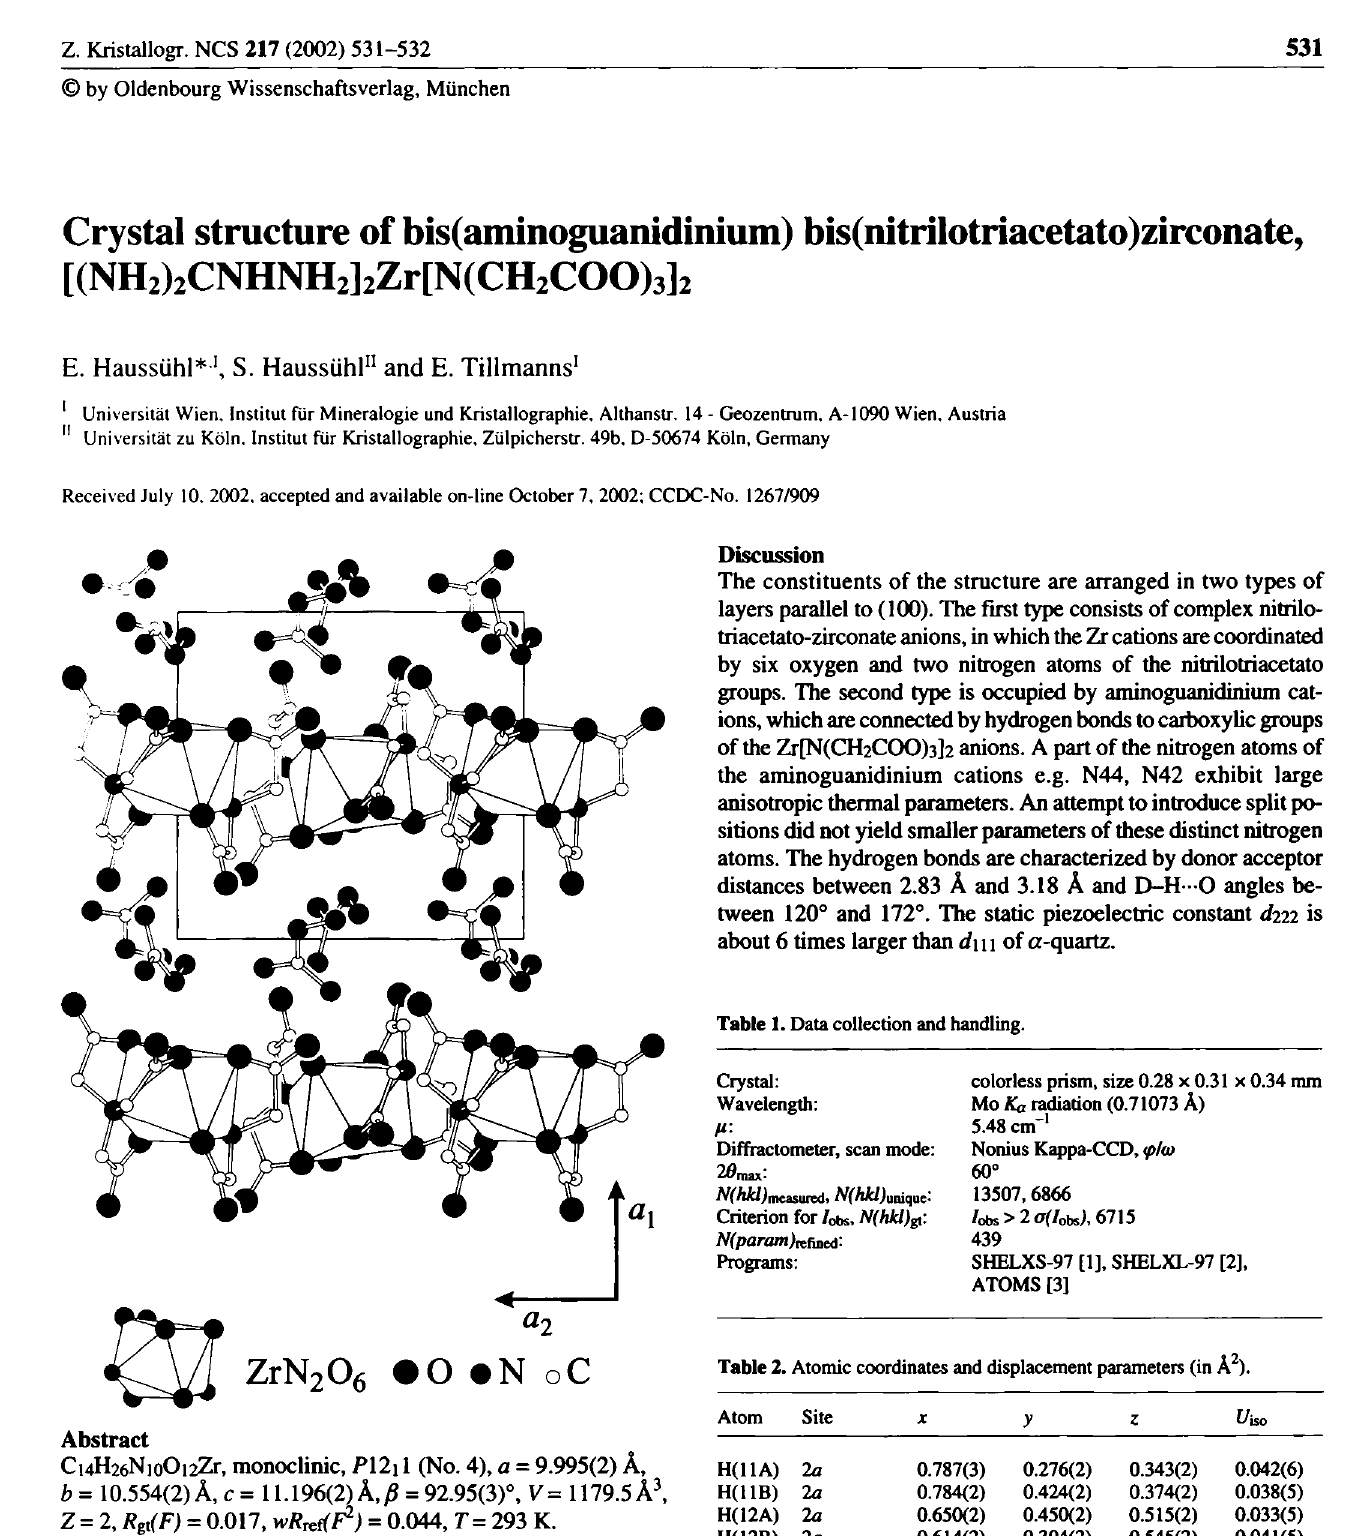
Table 2. Atomic coordinates and displacement parameters (in Â 2